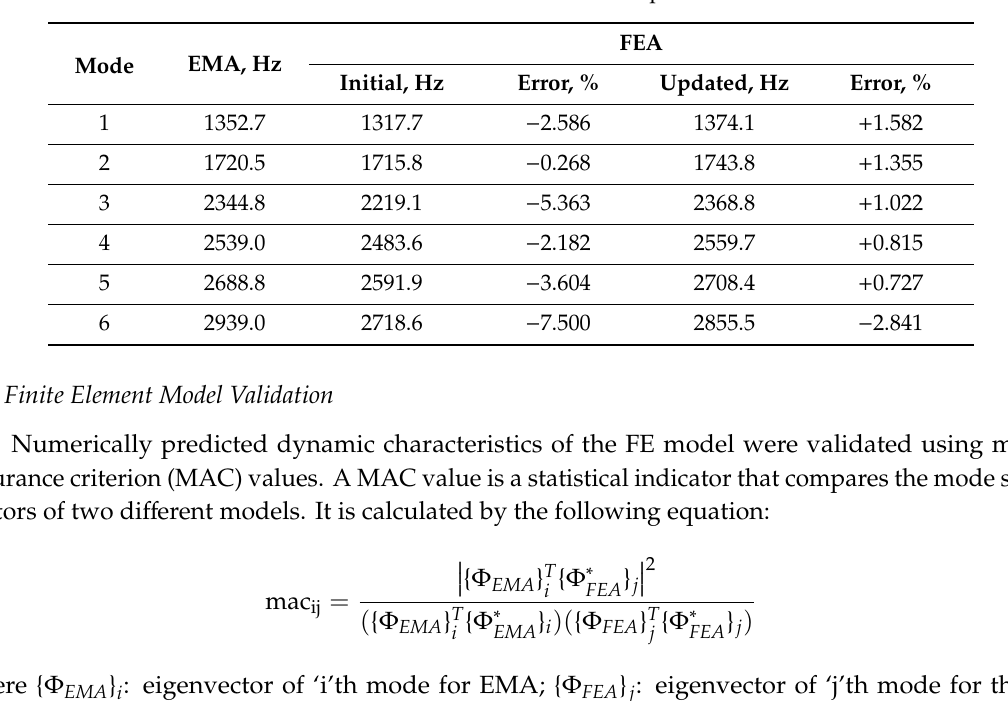
Table 4. Results of the FE model update.